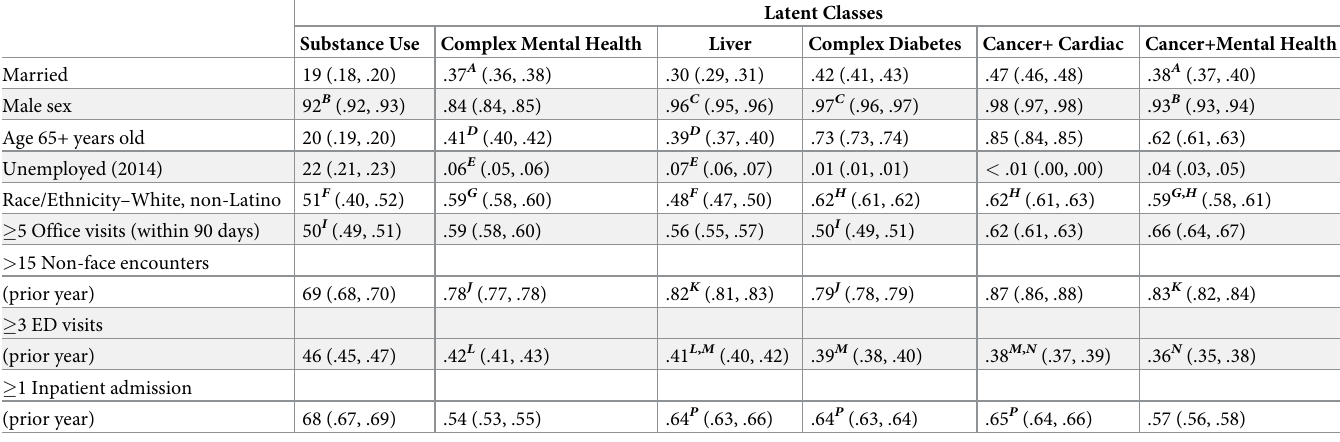
Table 4. Predicted probabilities (pp), with 95% confidence intervals, indicating the likelihood of the classes being in the listed categories of demographic and service utilization factors, based on multinomial logistic regression analyses (N = 62,579) 1